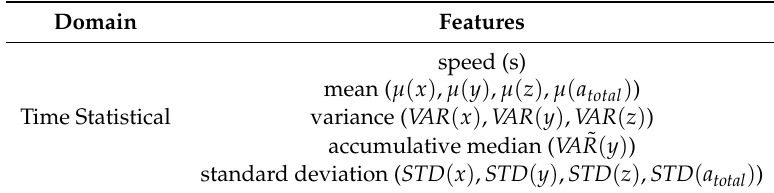
Table 2. List of features F w